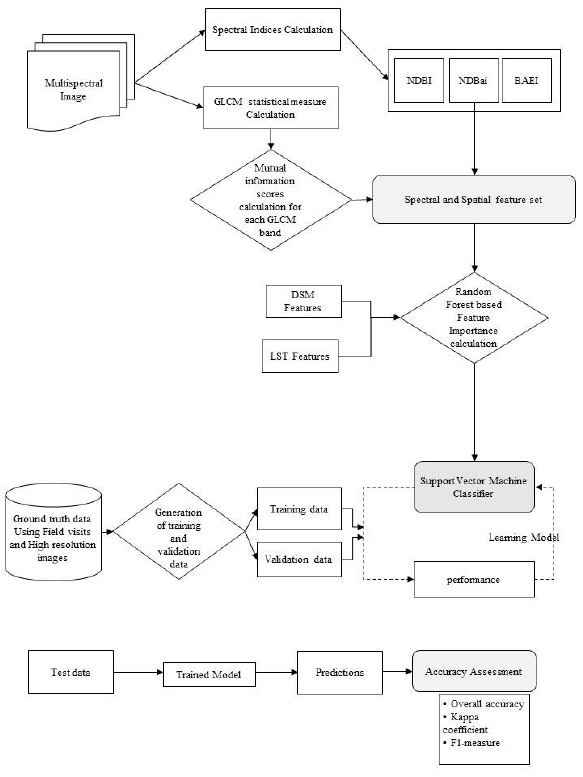
Figure 2. Flowchart of proposed approach for mapping of built- up